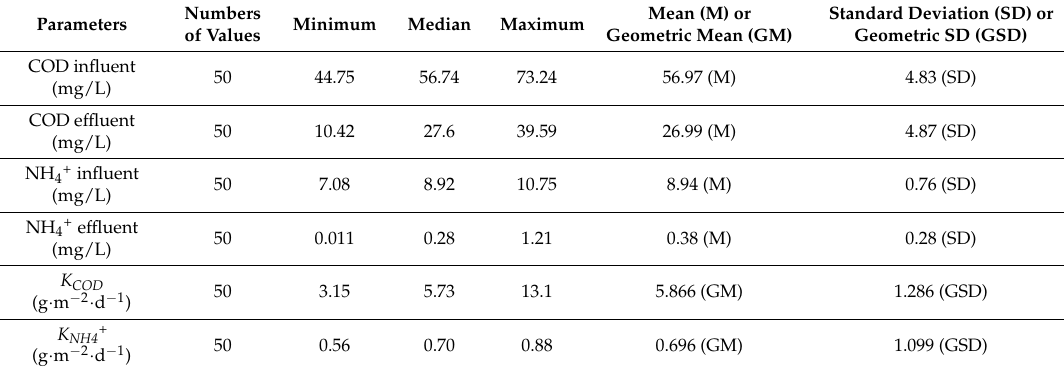
Table 2. Influent, effluent, and K values of COD and NH 4+ for PSCW